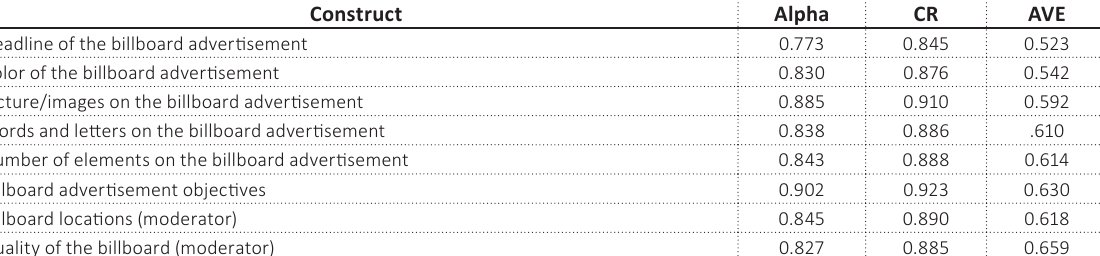
Table 2. Alpha, CR, and